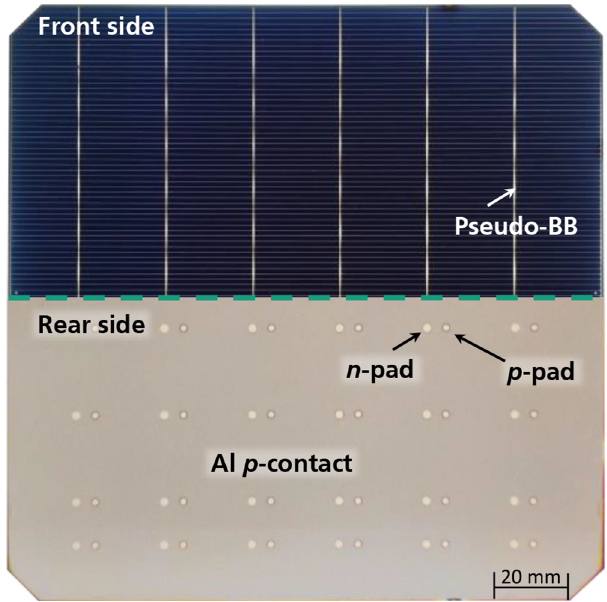
Fig. 2. Front and rear side of the manufactured HIP-MWT+ solar cell. Showing the front side metallization layout with 6 pseudo busbars on an M2 format p -type mono-crystalline silicon